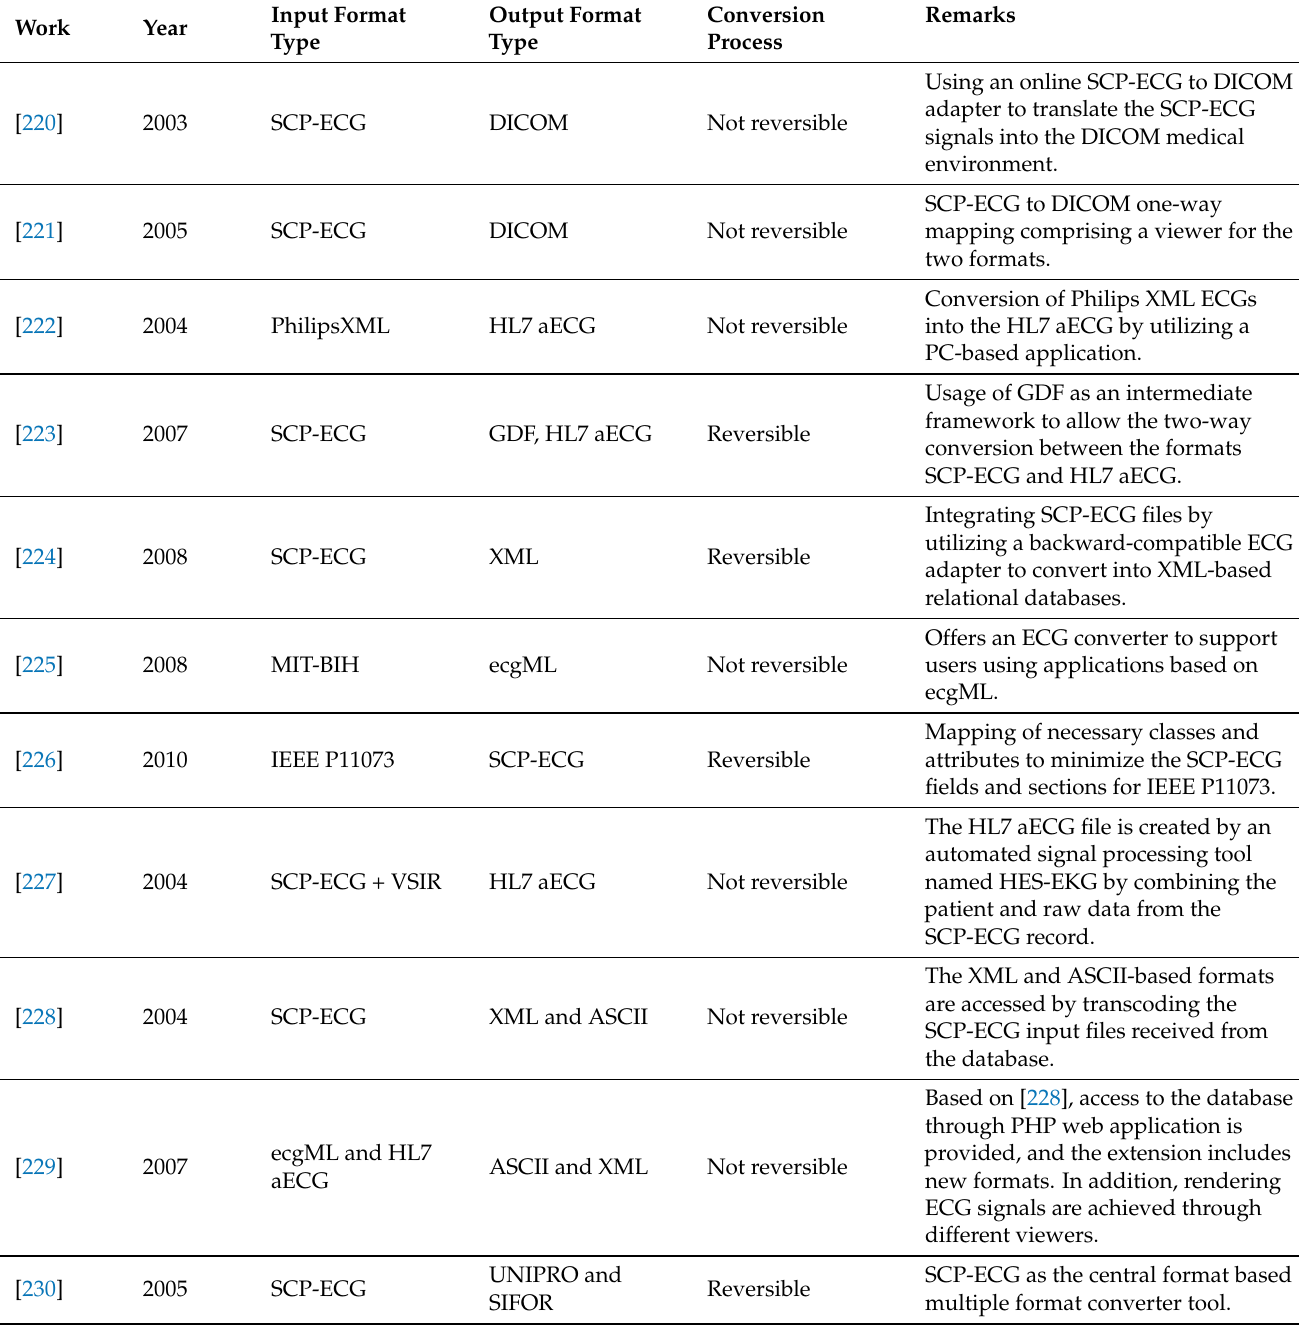
Table 7. Survey on existing ECG format